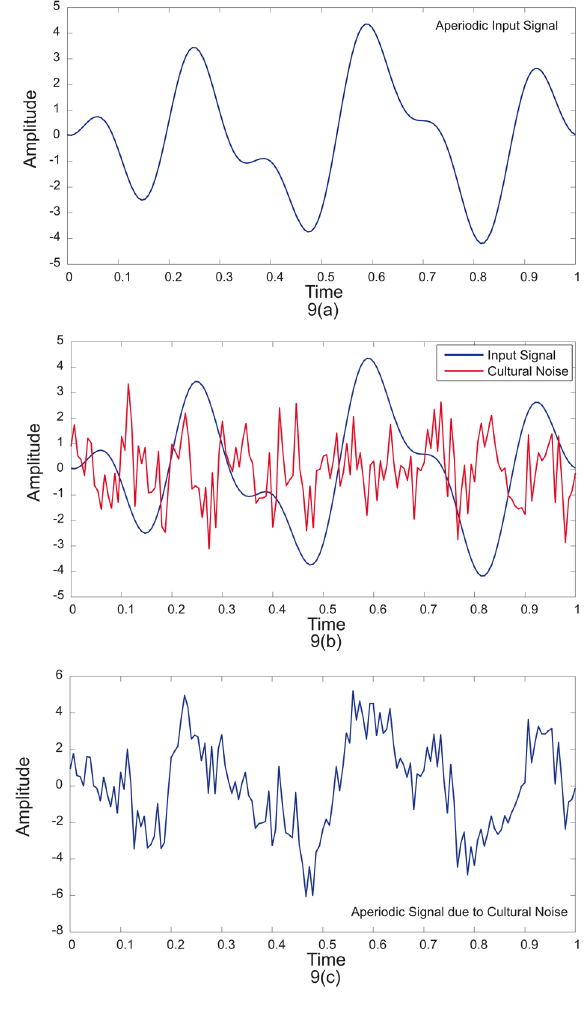
Figure 9. Effect of cultural noise on periodicity of input signal. (a) Aperiodic input signal. (b) Interaction of cultural noise with the input signal. (c) Aperiodicity of the signal increases after interaction of cultural